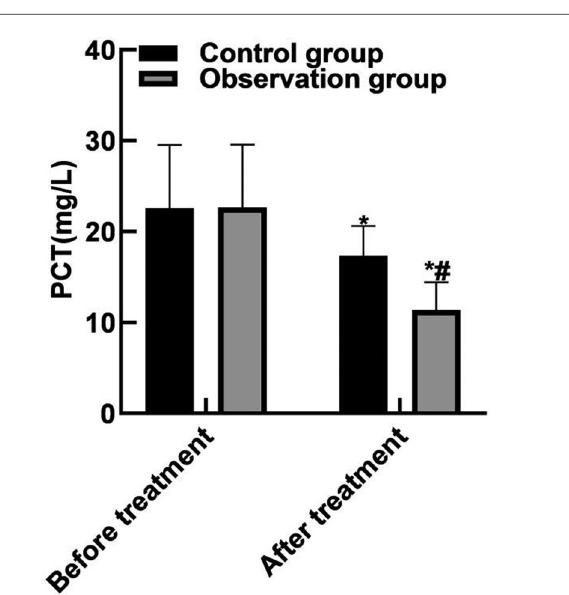
FIGURE 3 | Comparison of in fl ammatory factors. Note: Compared with before treatment, * P <0.05; Compared with the control group, # P <0.05.